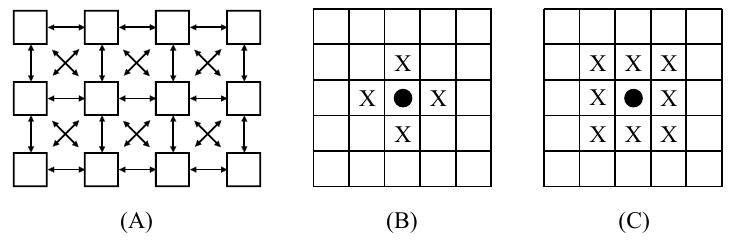
Figure 1. ( A ) Two-dimensional grid, ( B ) Von Neumann’s and ( C ) Moore’s